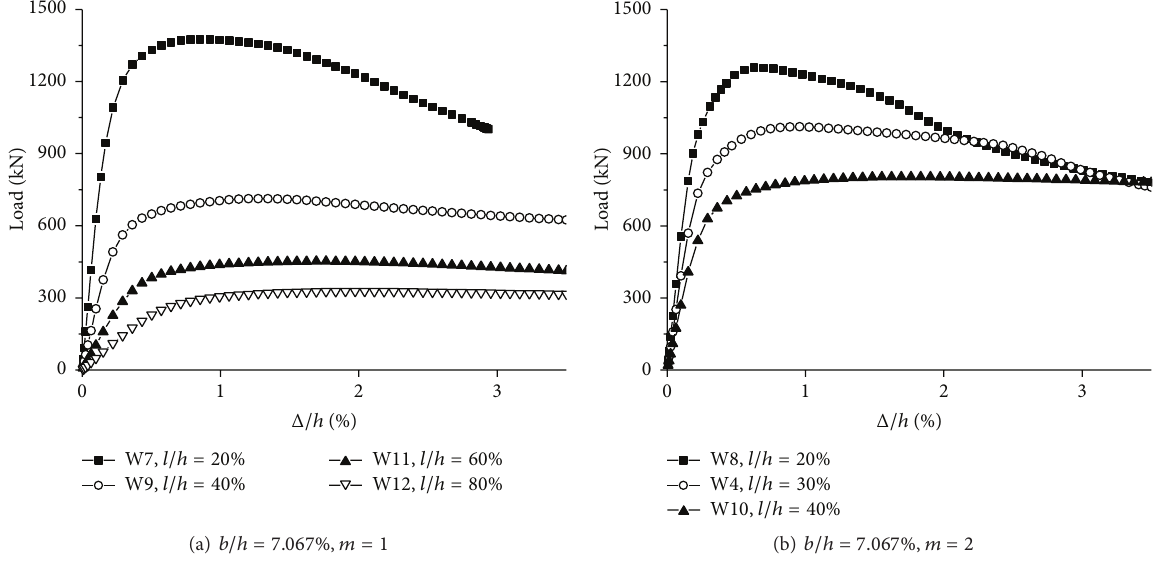
Figure 5: Pushover curves for steel slit wall with different 𝑙/ℎ .